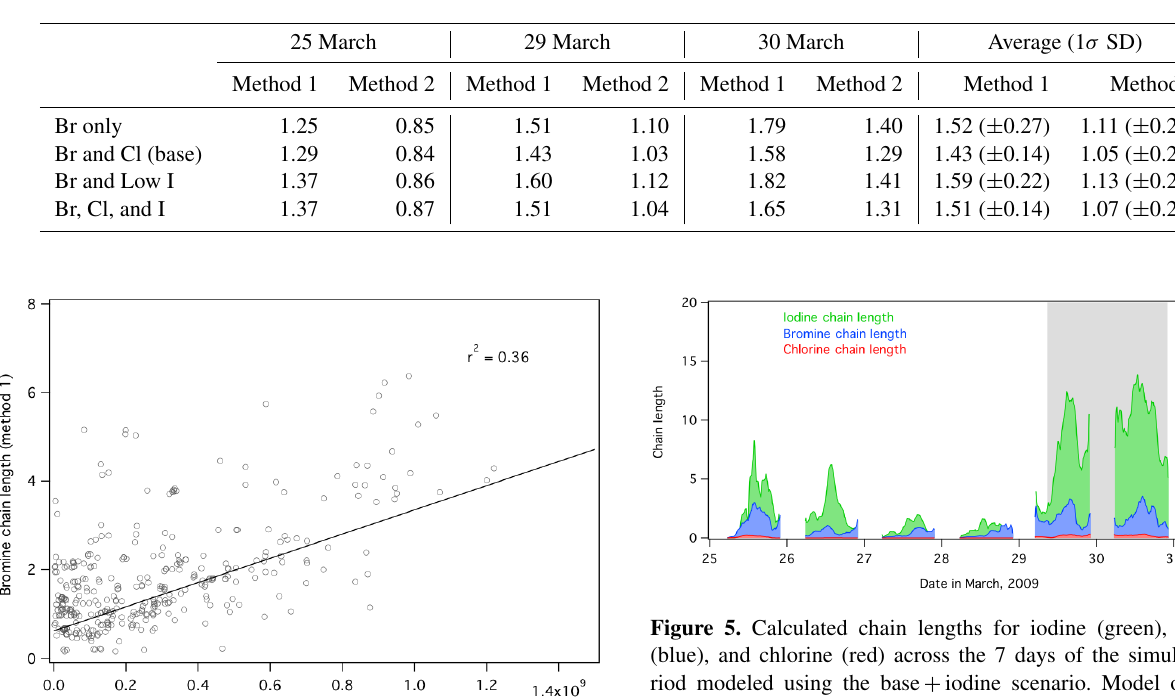
Table 2. Median afternoon bromine chain lengths for 25, 29, and 30 March 2009 (days with O 3 present) determined for four different modeling scenarios with different combinations of halogens present. Method 1 refers to Eq. (3) (using terminations reactions) and Method 2 refers to Eq. (4) (using initiation reactions).